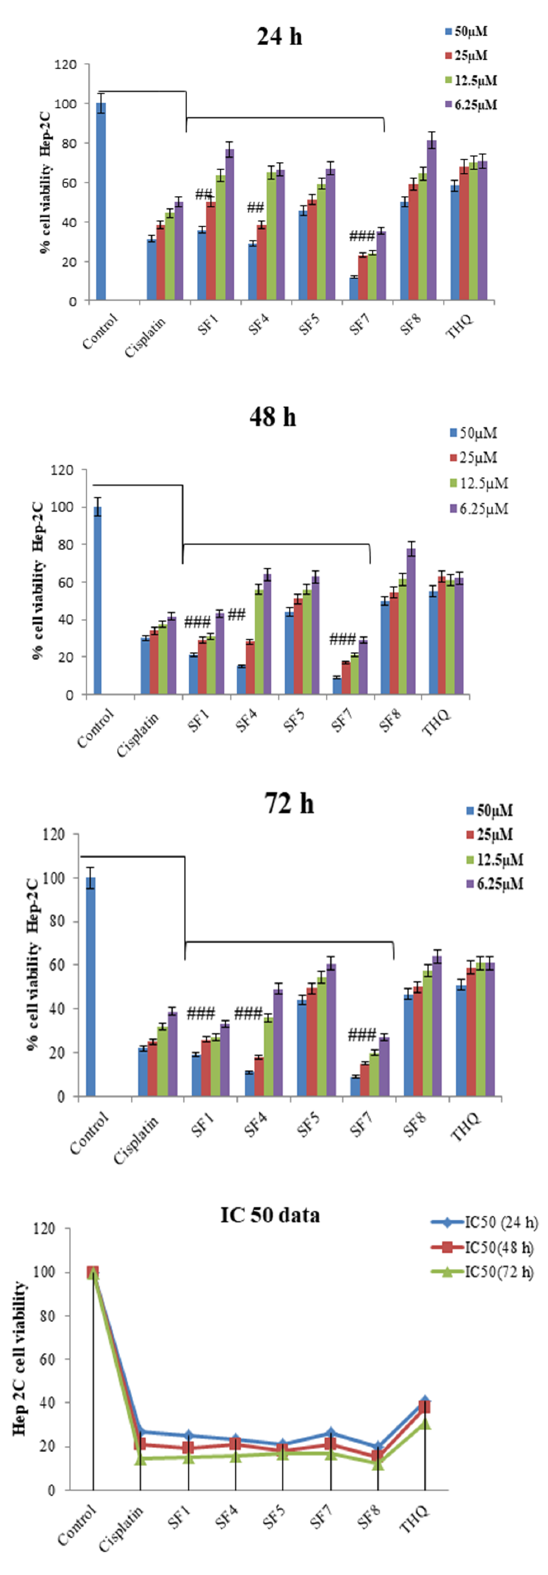
Figure 6. A 3-(4, 5-dimethylthiazol-2-yl)-2, 5-diphenyltetrazolium bromide (MTT) spectrophotometric assay of compounds ( SF1 , SF4 , SF5 , SF7 , SF8 ) at 50, 25, 12.5 and 6.25 µM concentration in Hep-2C cells. Data are reported as mean ± SD of each compound tested in triplicate. The symbols ### / ## indicates significance at p < 0.01 and p < 0.05,